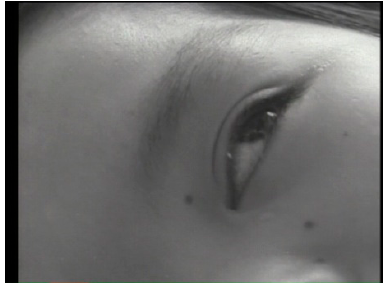
Figure 2. The extreme close-up of Kumiko’s right eye. Still from The Children of Minamata are Living (1965), director Tsuchimoto Noriaki.